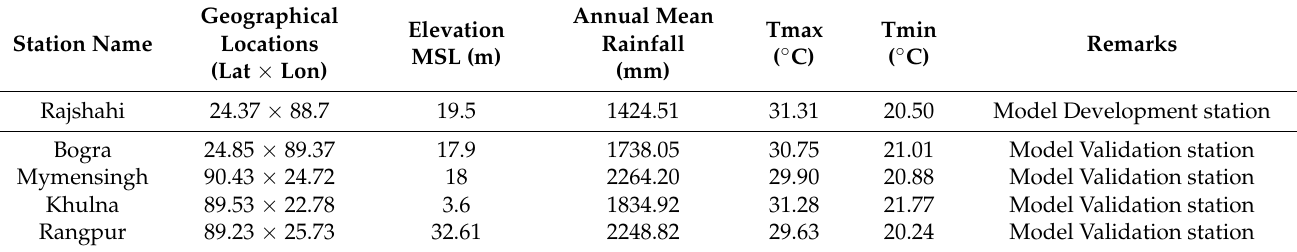
Table 1. Meteorological stations and descriptive statistics for rainfall and temperature.